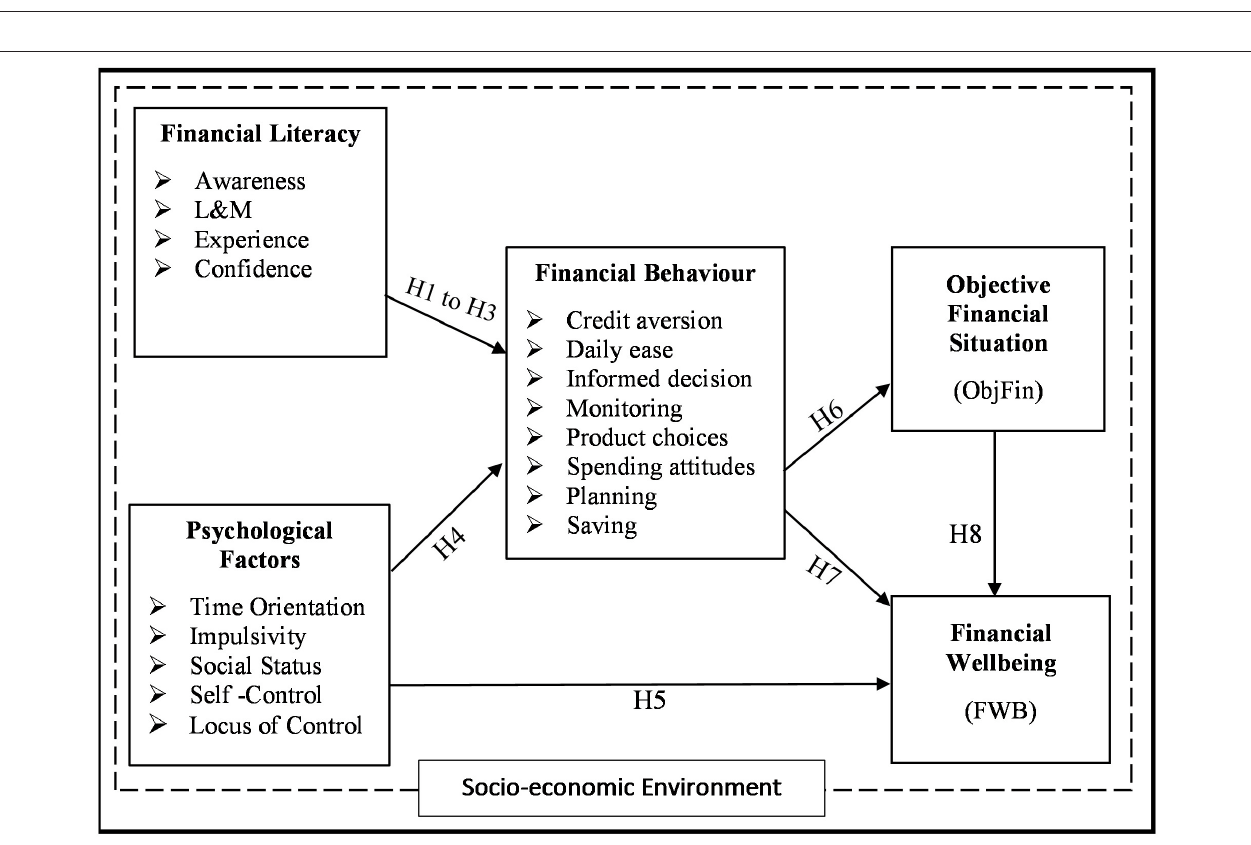
FIGURE 1 | The conceptual framework adapted from Deacon and Firebaugh (1988). Source: Self depiction.